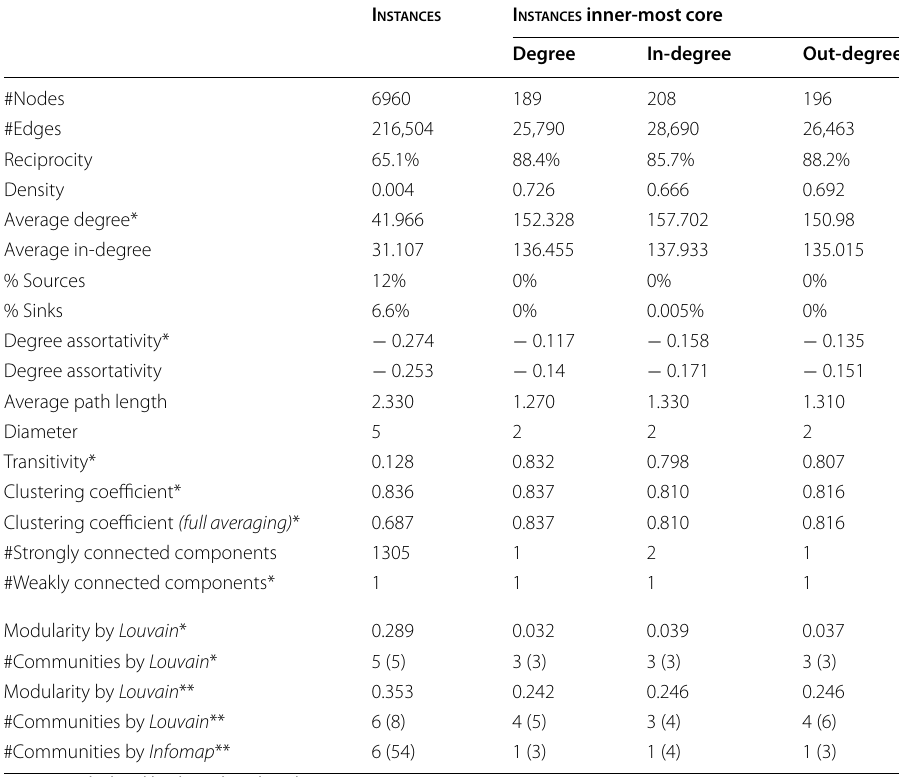
Table 3 Summary of structural characteristics of the I nstancEs network, including details on community structure and core